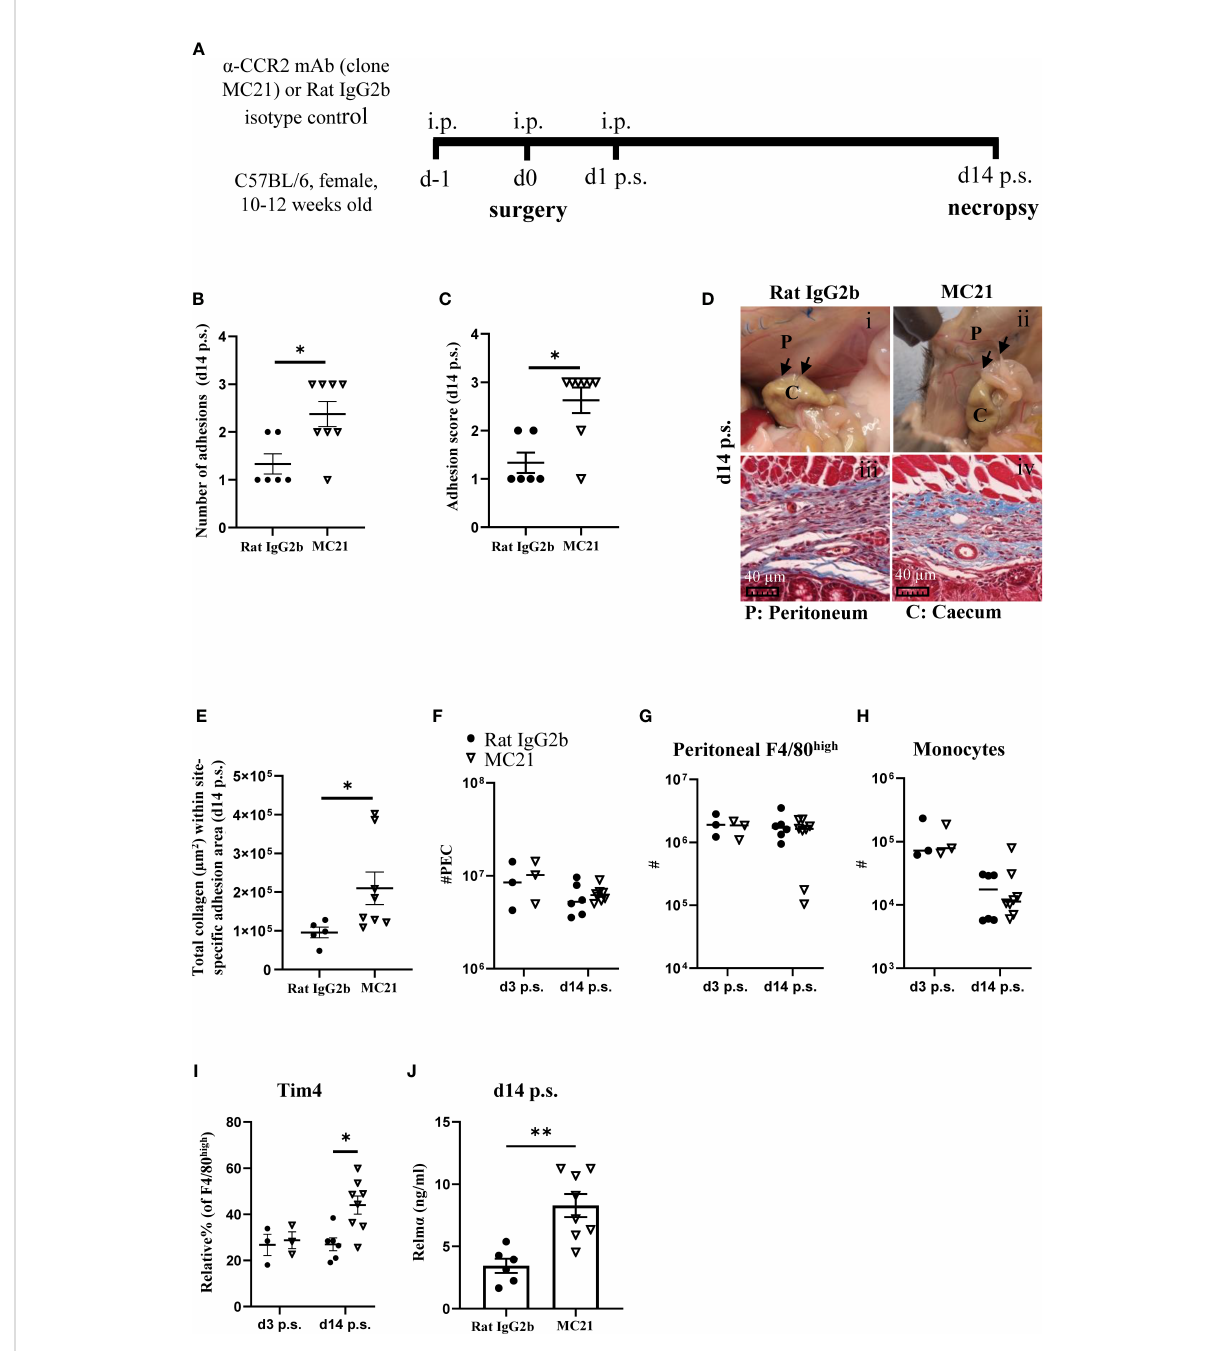
FIGURE 5 Depletion of monocyte-derived peritoneal macrophages enhanced susceptibility of C57BL/6 mice to peritoneal adhesions post-surgery. Schematic of experiment approach (A) . Number of adhesions (B) and adhesion score at day 14 post-surgery (C) . Representative image and corresponding histological appearance (Masson ’ s trichrome staining) of adhesions at day 14 in mice treated with CCR2-mAb or control IgG2b (D) . Collagen analysis in site-speci fi c adhesion histological sections at day 14 after surgery (E) . Total peritoneal exudate cells (F) . Total cell number of peritoneal F4/80 high resident macrophages (G) and monocytes (H) at day 3 and 14 post-surgery. Relative % of Tim4+ cells within F4/ 80 high population (I) . Level of Relm a in peritoneal lavage at day 14 (J) . Data shows mean ± SEM, pooled from 2 separate experiments, n= 6-8 mice/group; * P <0.05, ** P <0.01; (B, C, E, J) Mann Whitney test, (F – I) ANOVA with Tukey ’ s multiple comparison test. Scale bar 40 m